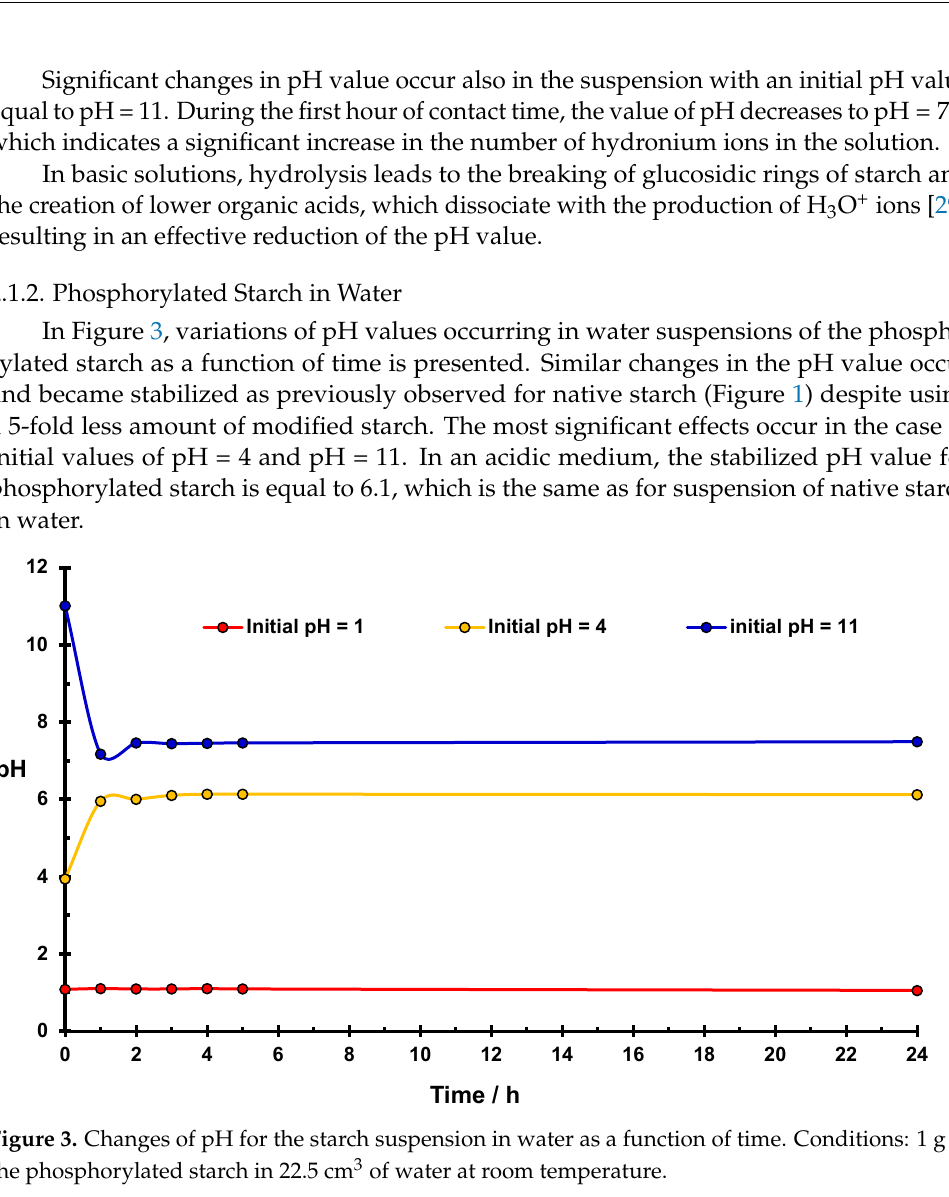
Figure 2. The effect of pH on the zeta potential of native and modified potato starch.